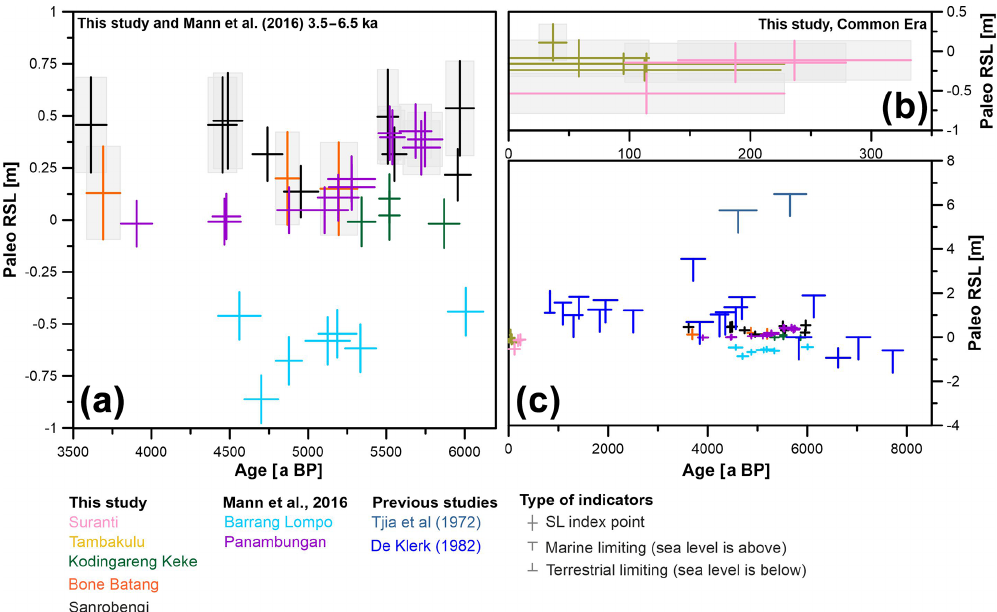
Figure 3. Representation of data reported in Tables 2 and 3. (a) RSL index points dating ∼ 6 . 5 to ∼ 3 . 5 ka and (b) Common Era microatolls surveyed in this study. Gray bands in (a, b) represent the microatolls that were recognized as eroded in the field and to which the erosion correction explained in the text has been applied. Panel (c) shows the newly surveyed data in the context of previous studies.